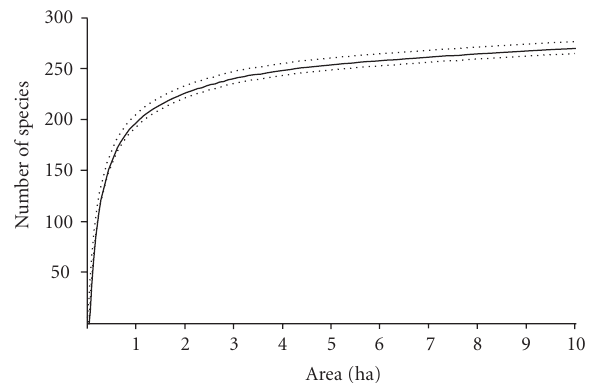
Figure 2: Sampling su ffi ciency designed by “jackknife” estimator for the ten sites of seasonal semideciduous forest in southeastern Brazil. Dashed line: standard deviation.